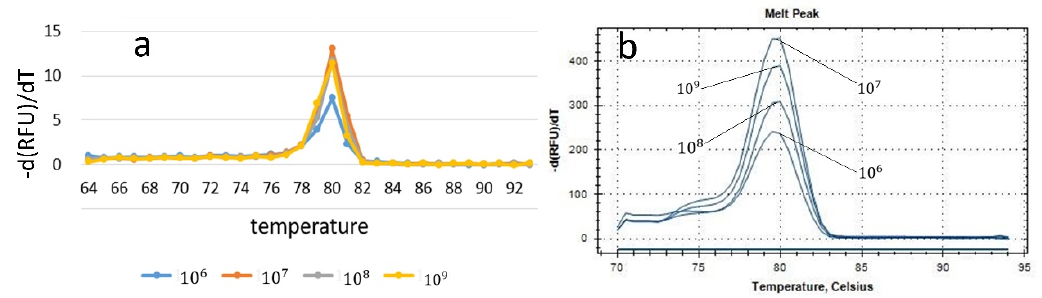
Figure 6. Fore gradient concentrations melting curve on ( a ) the portable PCR device and ( b ) the commercial instrument.